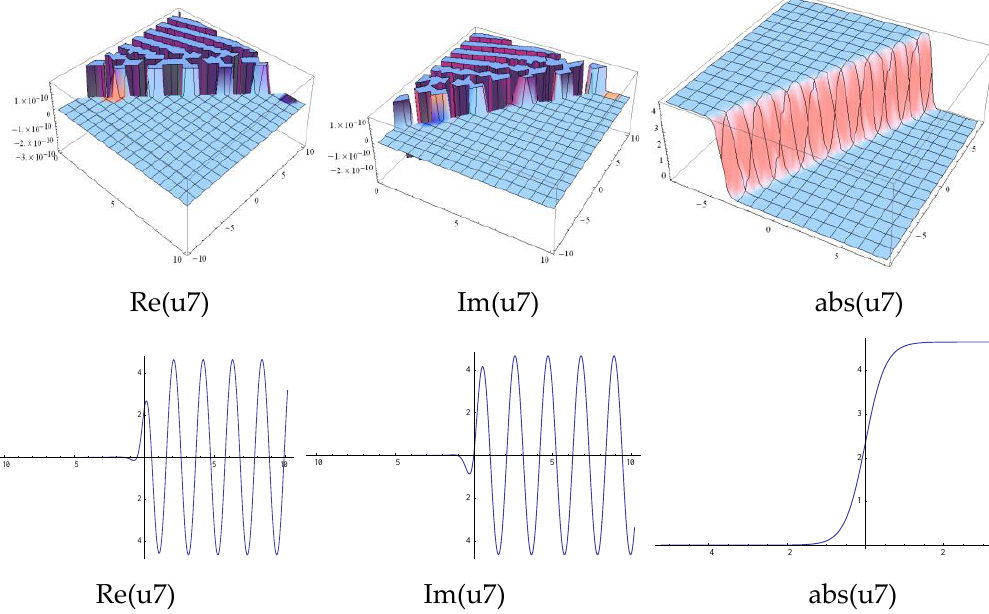
Figure 5. Solitary wave solution (51) of Equation (2) and its projection at 𝑡 = 0 when 𝐴 = −1, 𝐶 = 2, 𝑘 = 3,𝑝 = 2, 𝑞 = 0.5,𝜔 = 1, 𝑟 1 = 3,𝐴 1 = 5, 𝐴 2 = 6.